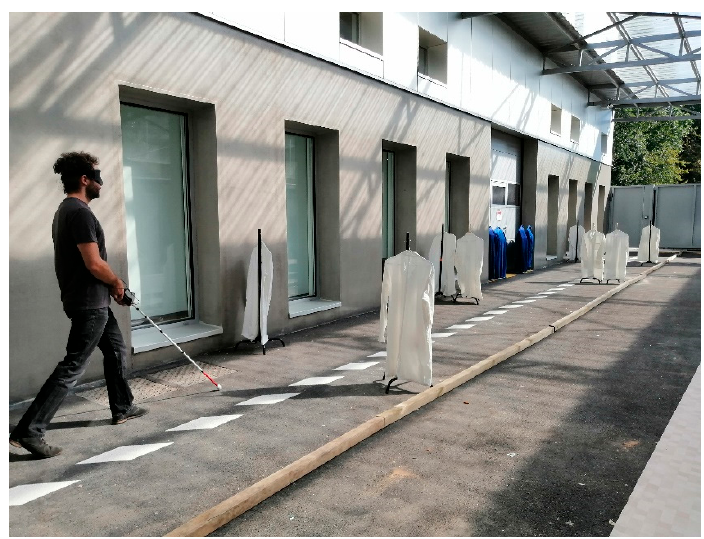
Figure 4. We see a participant walking down a 25 m long and 2.4 m wide path; 7 cm wooden square bars were positioned on the left side of the path, and a wall was on the right side. Obstacles made of lab coats on coat racks were placed along the path.